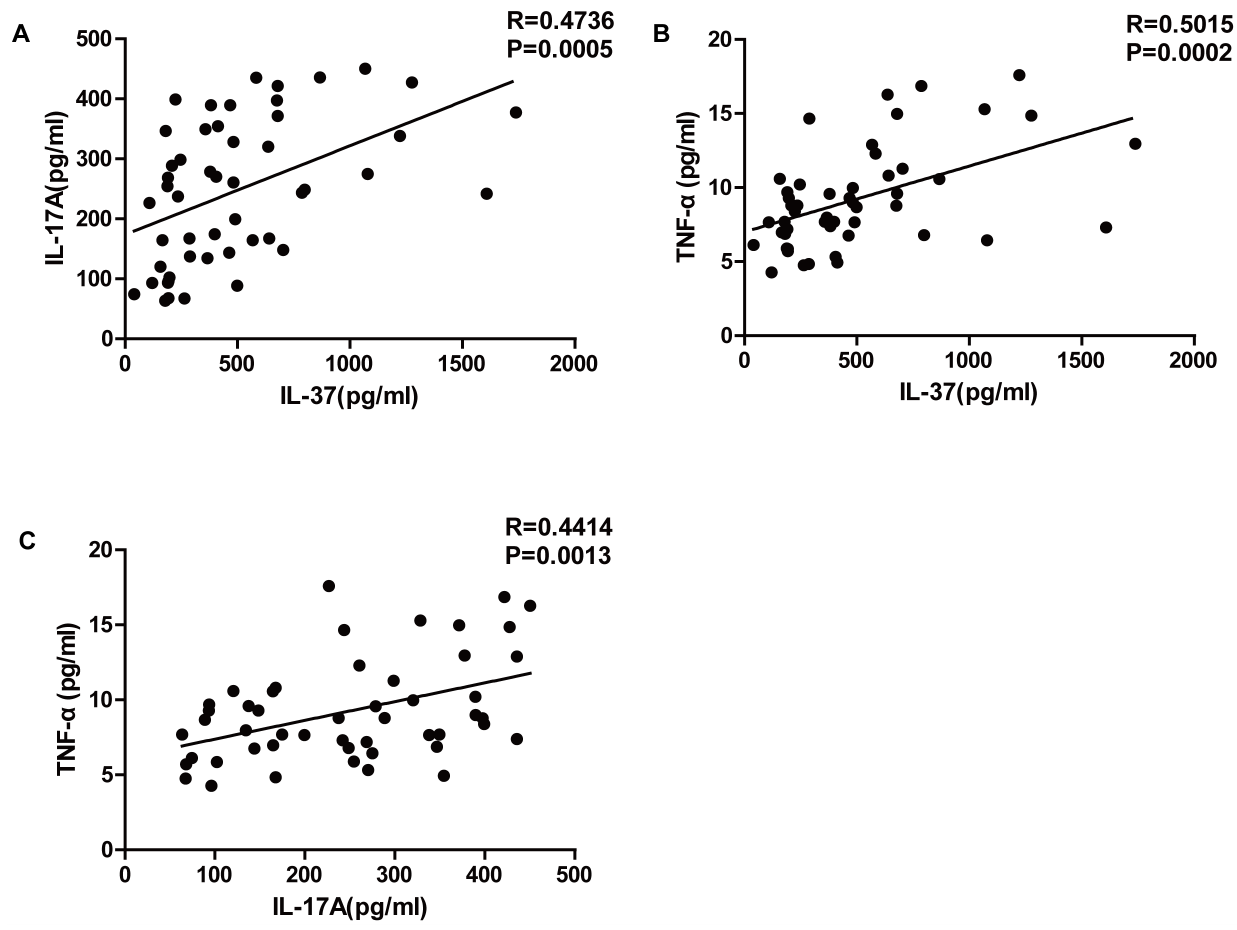
Figure 3. Correlation between IL-37 and other cytokines in RA patients. ( A ) Correlation between IL-37 and IL-17A in plasma of RA patients. ( B ) Correlation between IL-37 and TNF- a in plasma of RA patients. ( C ) Correlation between IL-17A and TNF- a in plasma of RA patients. The relationship between variables was evaluated using the Spearman rank correlation test. positively correlated with IL-17A (Fig. 3A, R= 0.4736, P= 0.0005) and TNF- a (Fig. 3B, R= 0.5015, P= 0.0002) levels. Additionally,